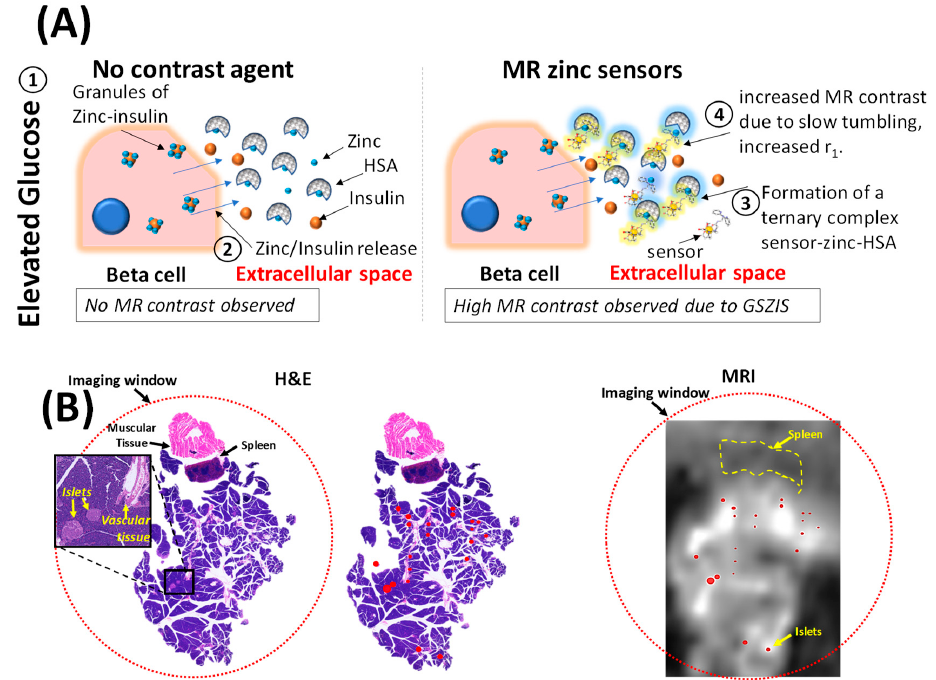
Figure 5. Schematic illustrating the phenomenon observed in vivo from β -cells during glucose-stimulated zinc/insulin secretion: insulin (brown spheres) and Zn 2+ (cyan spheres) release. Ternary complex highlighted in yellow and blue (right) ( A ). Histological staining; islets labelled in red ( B ) (left). MRI of slice of tissue showing functional zinc release from the β -cells in the islets in the presence of the low affinity zinc sensor GdDO3A-PEPMA ( B ) (right). Adapted with permission from [12]. Copyright 2018 American Chemical Society.